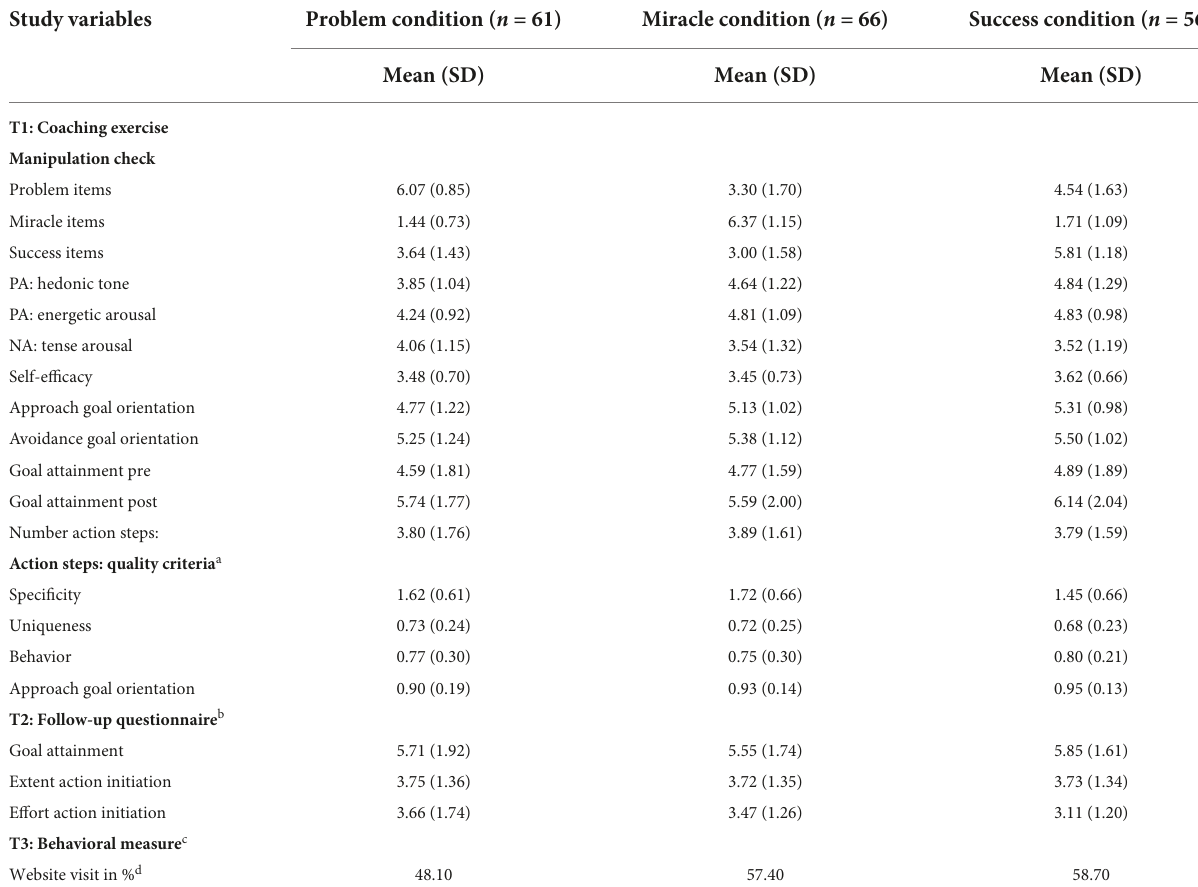
TABLE 1 Means and standard deviations of the key study variables in all three